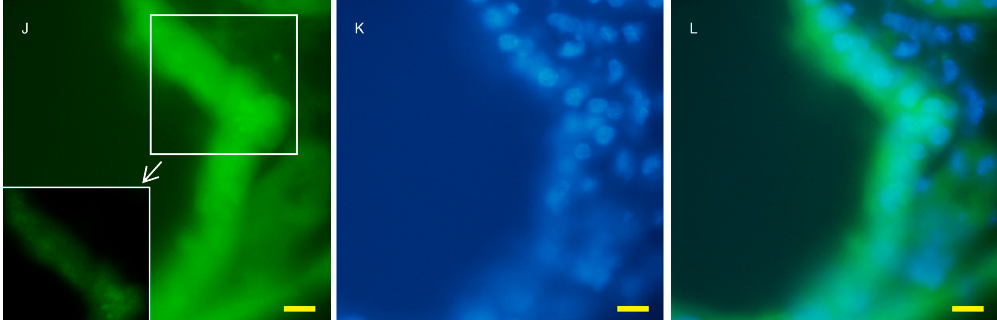
Figure 4. Fluorescent microscopy of the kidney cortex of GFP-LC3 transgenic mice that were crossed with AQP11 knockout or wild-type mice at seven weeks old. Green fluorescence shows GFP-LC3 ( A , D , G , J ), while blue fluorescence indicates nucleic staining ( B , E , H , K ). Both images are merged ( C , F , I , L ); A – F are wild-type and G – L are AQP11 knockout mouse; A – C and G – H are at the lower magnification, while D – F and J – L are at the higher magnification. The asterisks indicate the distal tubule ( I ). The left lower frame of J showed enlarged puncta of GFP which were expressed in the proximal tubule. Bars indicate 50 and 10 μ m length at each magnification. The asterisk indicates the distal tubule. Similar observations were made in three separate sets of experiments.